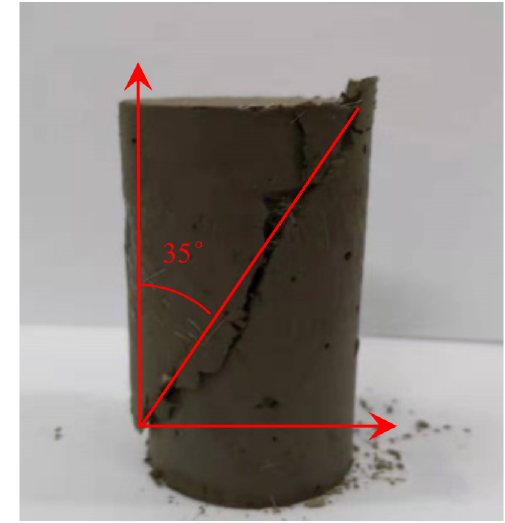
Figure 4. Failure diagram of sample after UCS